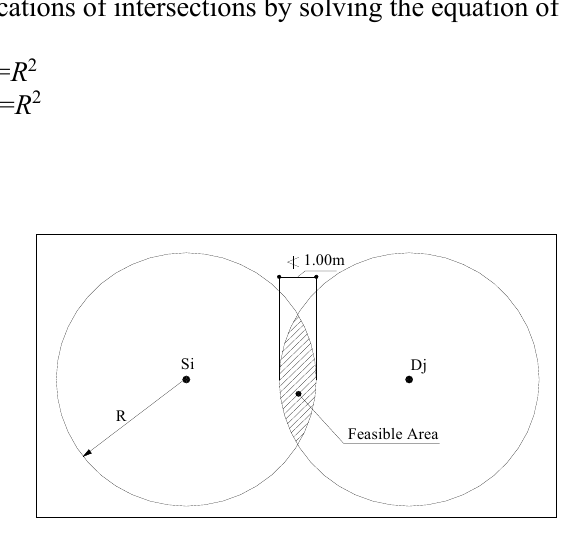
Fig. 2. Specified feasible area to locate the crane (Irizarry & Karan,